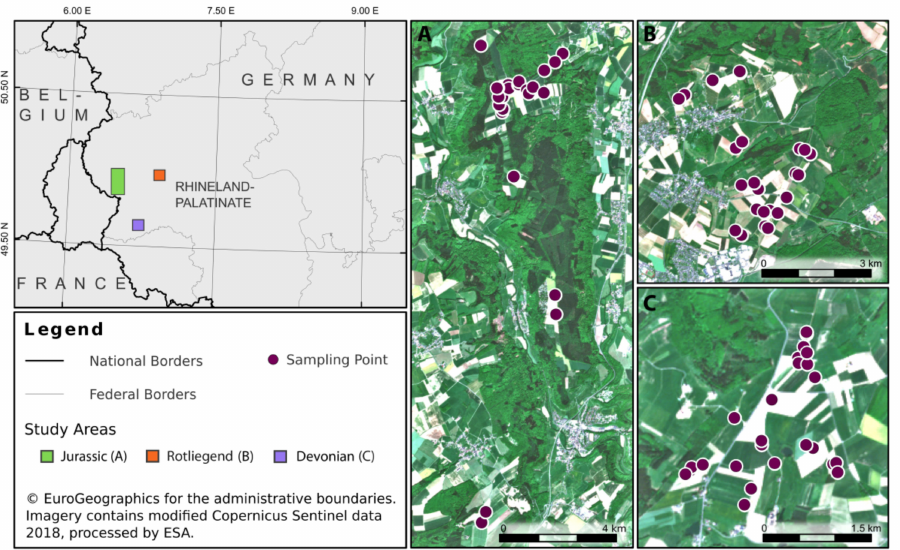
Figure 1. Soil sampling sites in western Rhineland-Palatinate, Germany, stratified for different geological origins, with individual sampling locations ( n = 75) illustrated in panels A–C.